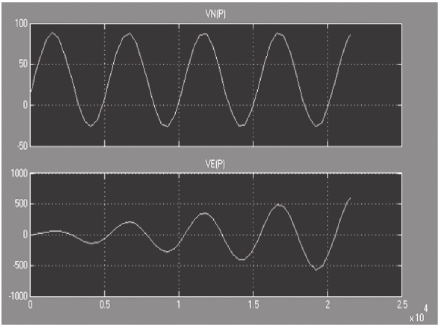
Fig. 7. Graphs of error rates of the two channels of an inertial system when between the channels there is only one cross-link with transmission factor KprV (knpv = 0.001)